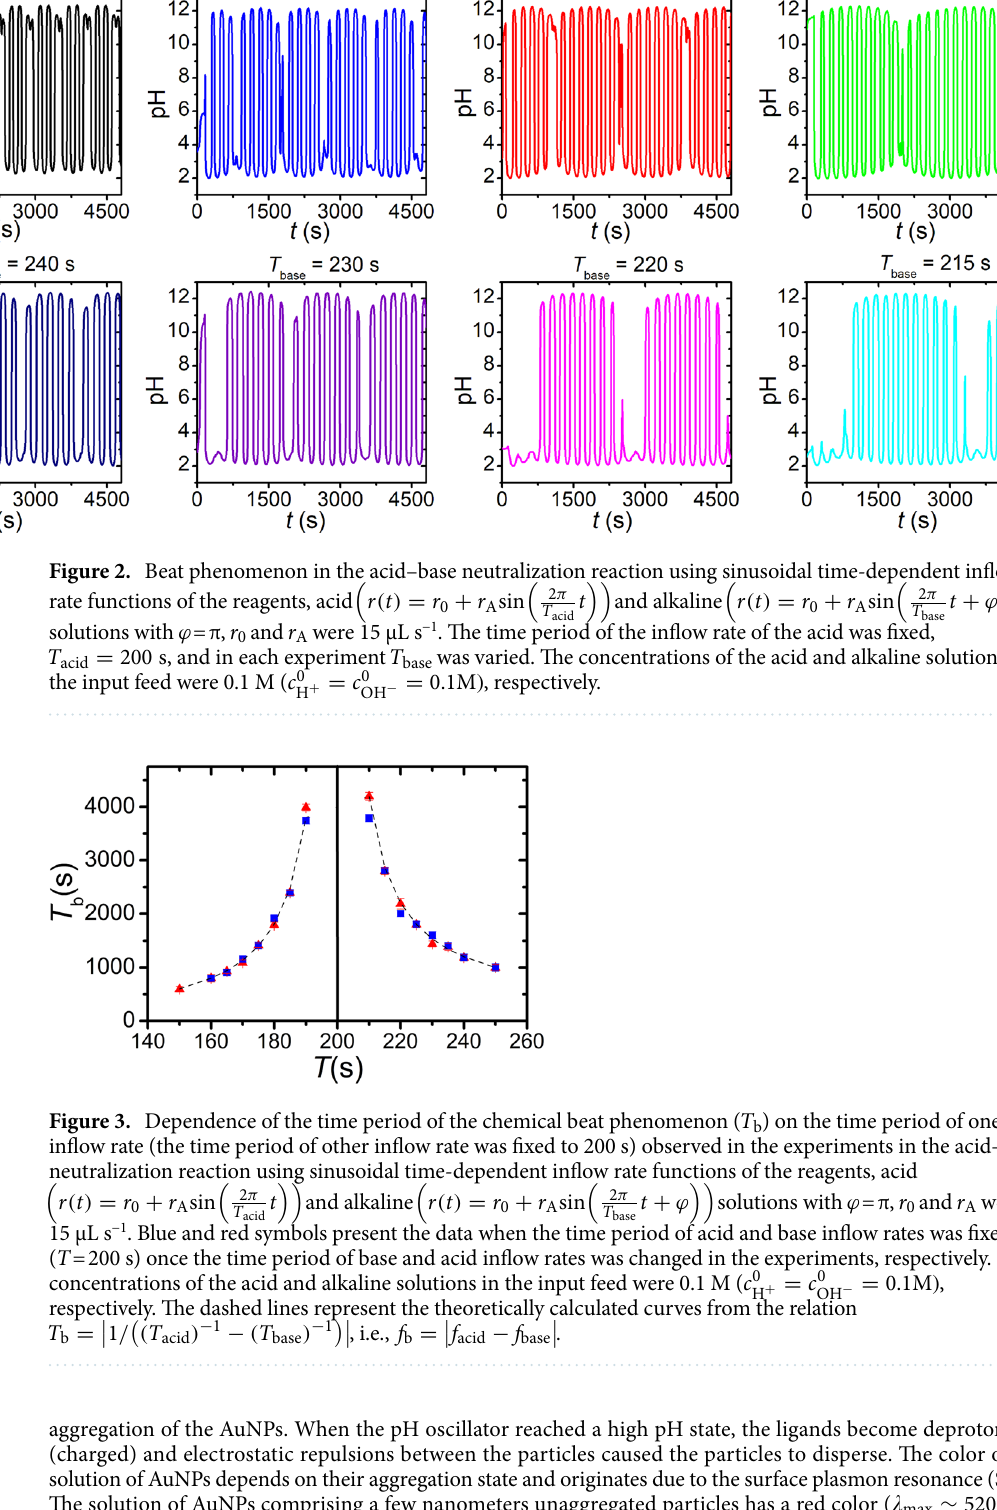
aggregation of the AuNPs. When the pH oscillator reached a high pH state, the ligands become deprotonated (charged) and electrostatic repulsions between the particles caused the particles to disperse. The color of the solution of AuNPs depends on their aggregation state and originates due to the surface plasmon resonance (SPR). The solution of AuNPs comprising a few nanometers unaggregated particles has a red color ( (cid:31) max ∼ 520 nm ), when these AuNPs aggregate forming clusters, the color of the solution changes from red to blue, which causes an absorbance decrease at (cid:31) max . In other words, the pH oscillations translated into the rhythmic aggregation/ dispersion of the AuNPs, which generated color oscillation of the solution and absorbance oscillation at a fixed wavelength (Fig. 5b).